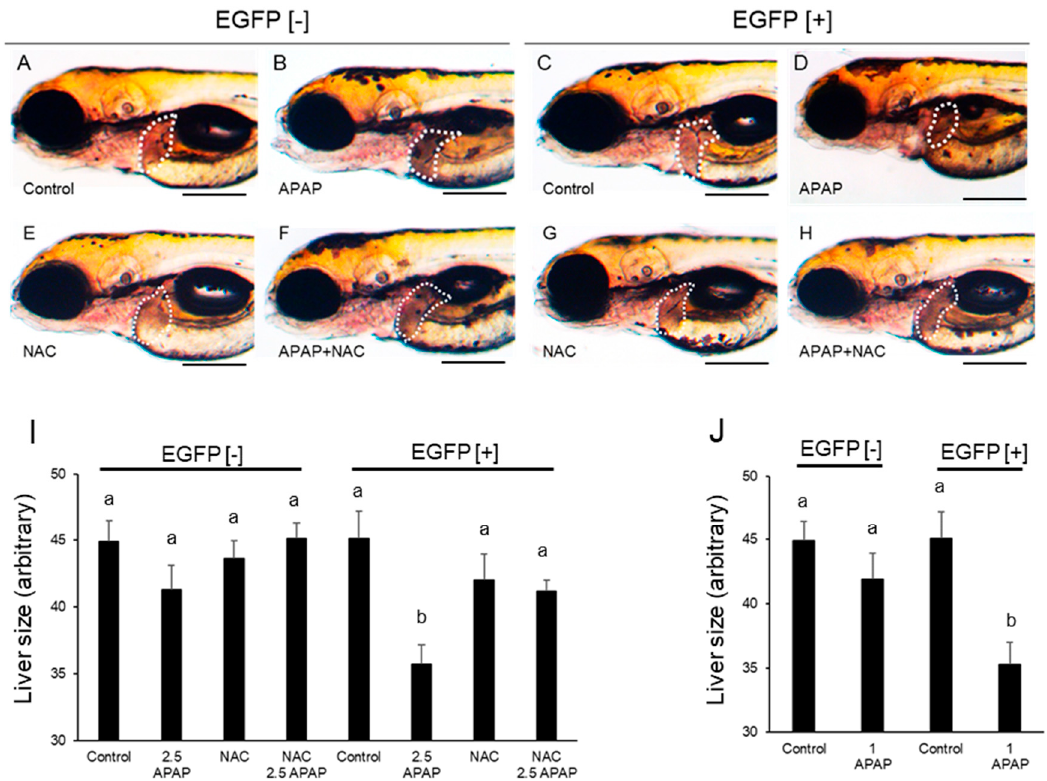
Figure 4. Acetaminophen-induced reduction in the size of the liver in rat CYP2E1-TG larvae and effects of N -acetylcysteine. EGFP fluorescence-negative (EGFP [ − ]) and -positive (EGFP [+]) F2 CYP2E1-transgenic larvae were exposed to acetaminophen (APAP) from 48 hpf to 96 hpf for